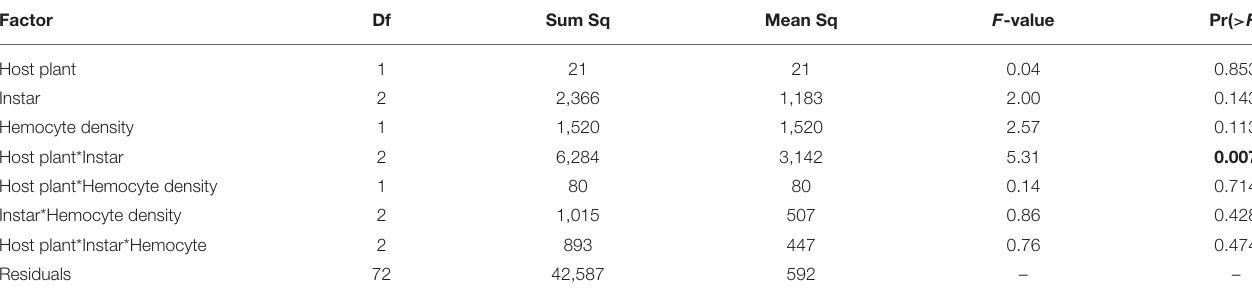
TABLE 2 | In September ANCOVA indicated only an interaction between host plant and caterpillar developmental instar on melanization. Factor Df Sum